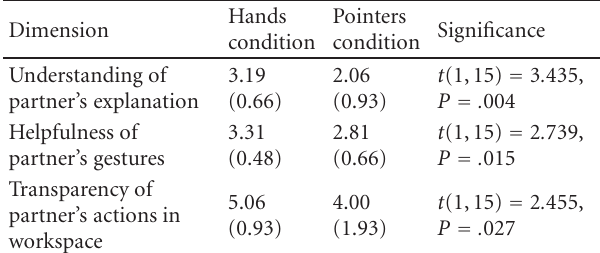
Table 4: Helper perception of the interaction in the two conditions (Reported are means and (standard deviation), the range was